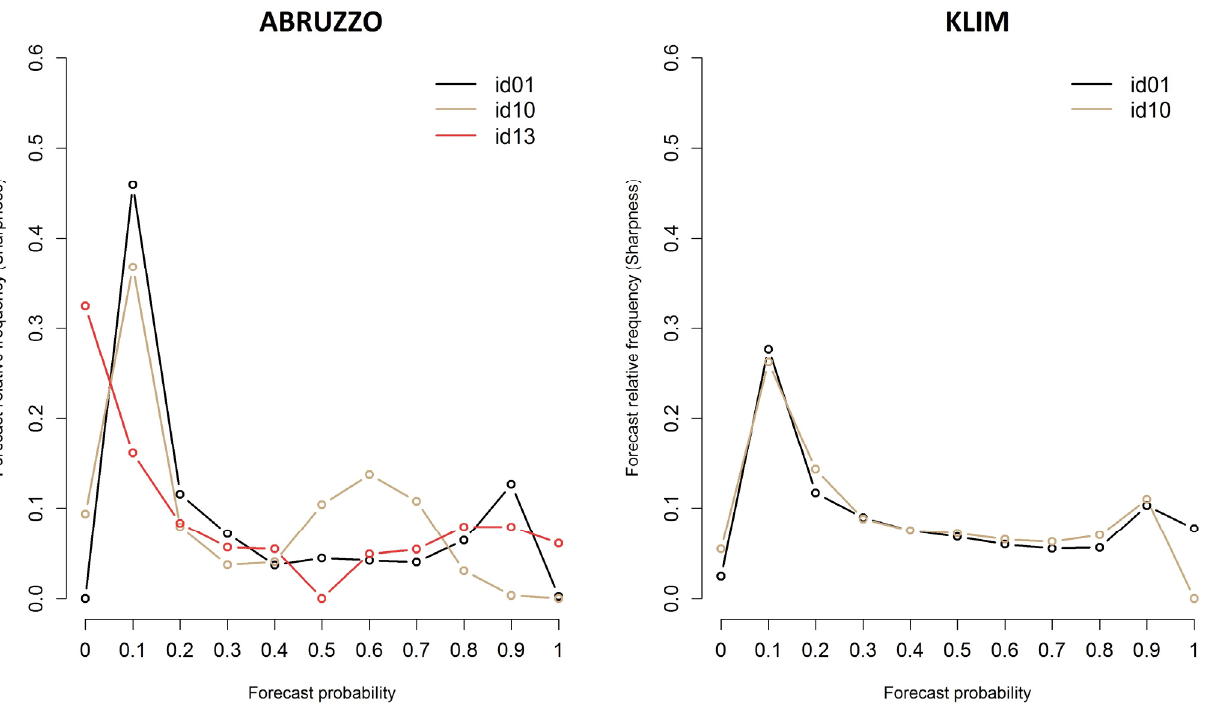
Figure 14. Sharpness diagrams for Abruzzo ( left ) and Klim ( right ). Mean produced power is used as threshold